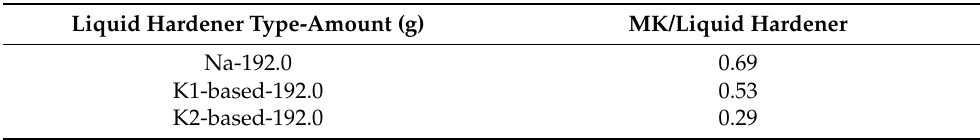
Table 5. Mix design proportions for liquid hardener and